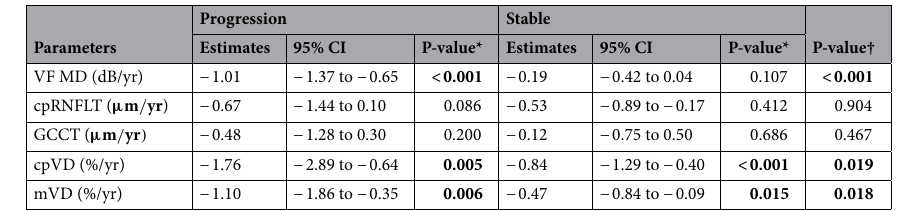
Table 2. Comparisons of rates of change in VF MD and OCT/OCTA-derived parameters between eyes with and without visual field progression in 75 POAG eyes using age-adjusted linear mixed-effects